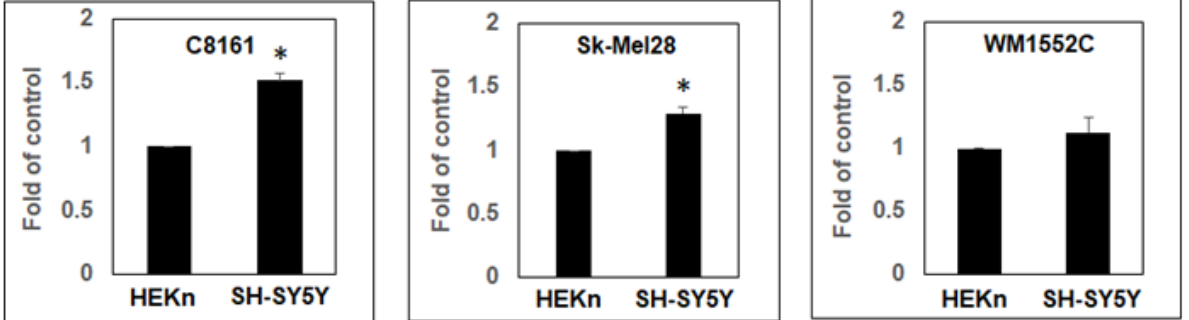
Figure 2. Netrin-1 is a chemoattractant for C8161 and Sk-Mel28 aggressive melanoma cells. Results from cell migration assay show that the treatment with exogenous, soluble rhNetrin-1 at 50, 100, and 200 ng/mL is associated with a dose-dependent increase in migration of ( A ) C8161 ( n = 3) and ( B ) Sk-Mel28 ( n = 2) aggressive melanoma cells (* p < 0.05) compared to control. Representative mi- crophotographic images at 10x magnification show increased numbers of the migrated crystal vio- let-stained C8161 ( A ) and Sk-Mel28 ( B ) aggressive melanoma cells towards 200 ng/mL of rhNetrin- 1. ( C ) Further results from cell migration assays show significantly greater migration of C8161 ( n = 3) and Sk-Mel28 ( n = 3) aggressive melanoma cells towards the Netrin-1-expressing SH-SY5Y cells